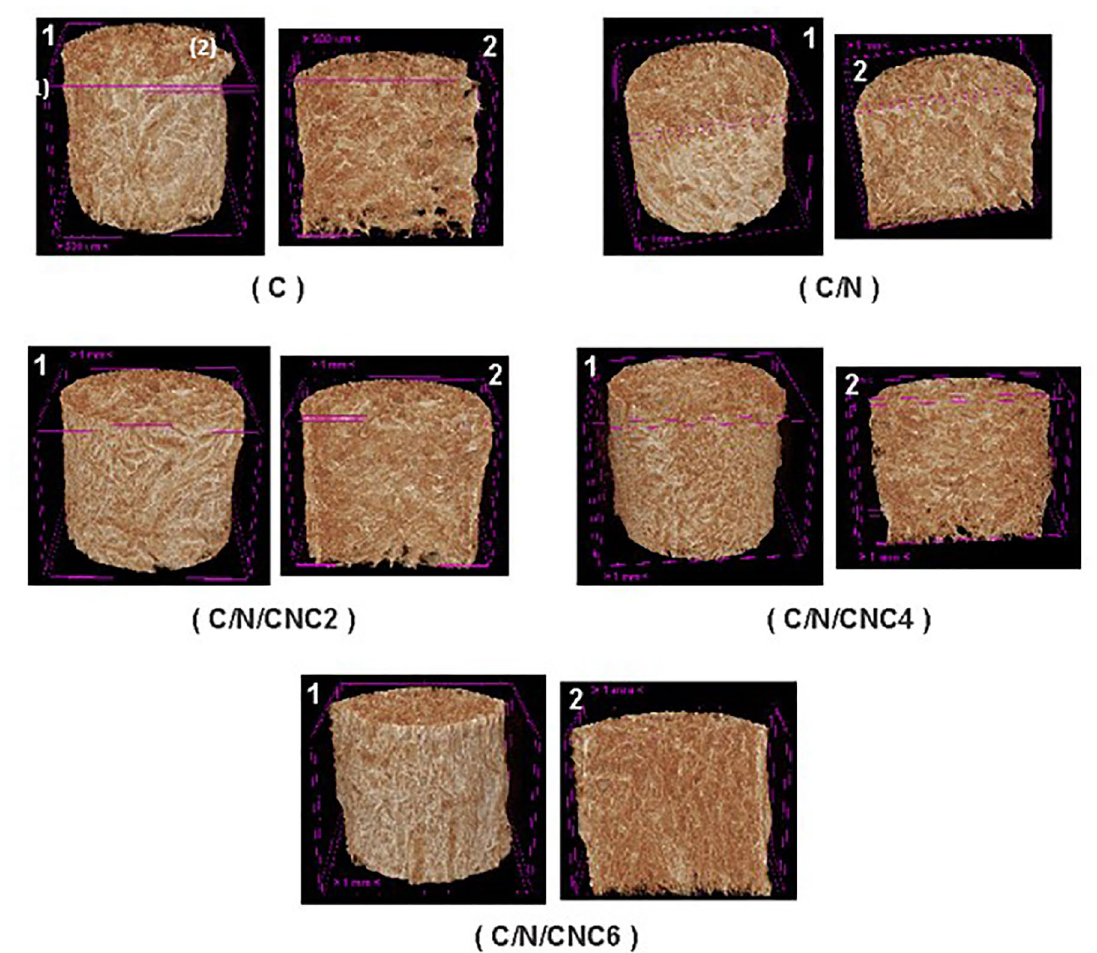
Figure 4. 3D view of C, C/N, C/N/CNC2, C/N/CNC4 and C/N/CNC6 hydrogels. Front view (1) and cross section (2).